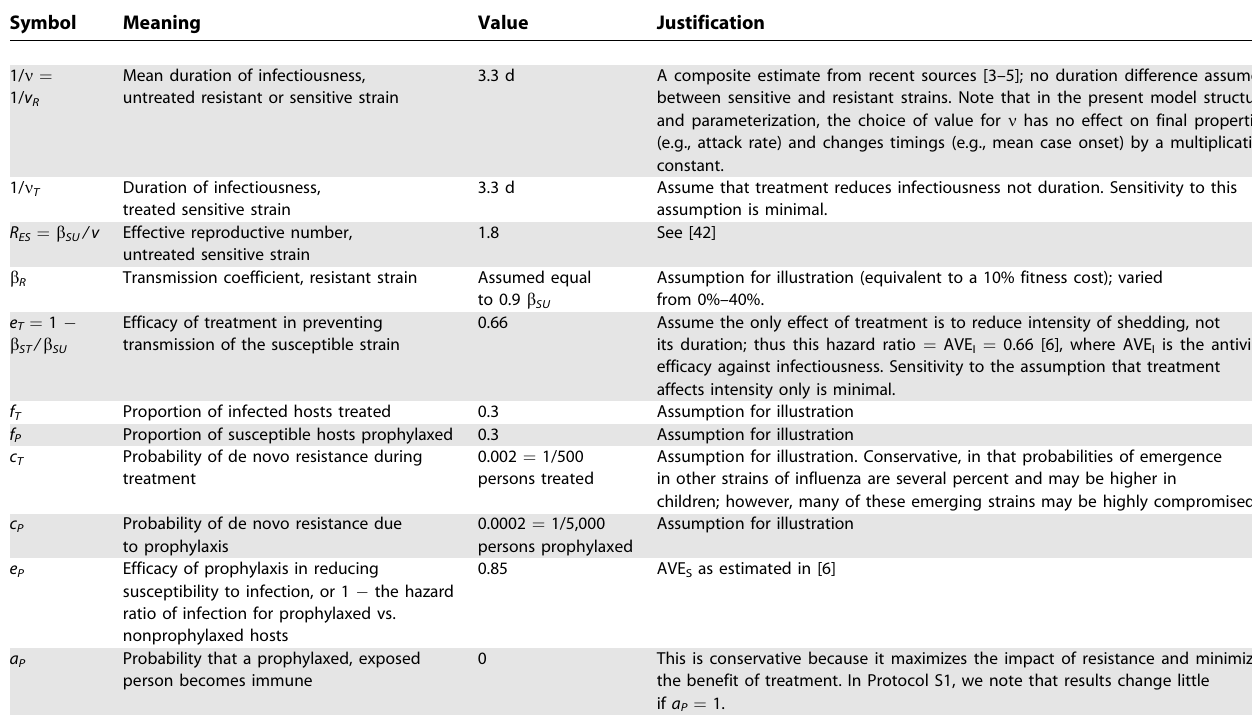
Table 1. Baseline Parameters Used in the Numerical Examples Symbol Meaning Value